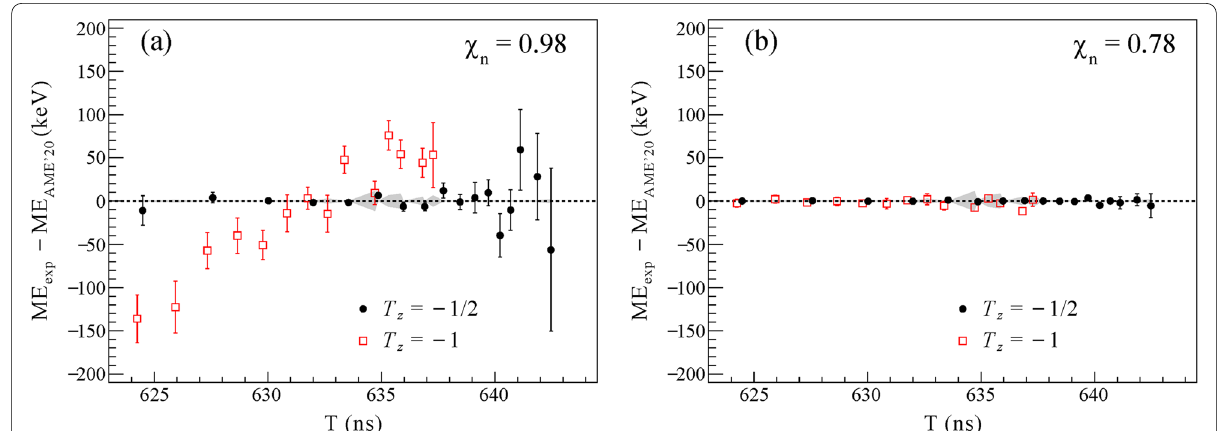
Fig. 12 Mass excesses (ME) of T Z 1 nuclides (red open squares) and T Z 1/2 nuclides (black dots), represented with respect to the values in = − = − AME2020 [57]. Left, results obtained with the conventional IMS. Right, results with the B ρ-defined IMS. The gray shadow shows the uncertainties in AME2020